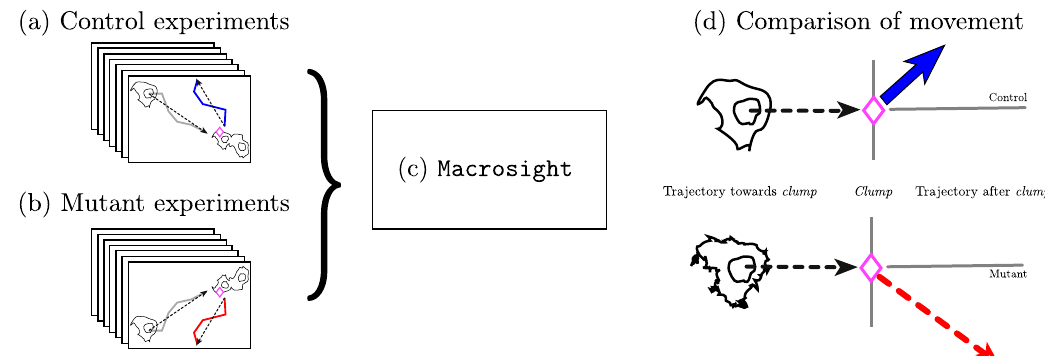
Figure 1. Illustration of the main hypothesis in this work. Different movement patterns from control and mutant samples are expected as a result of the movement analysis performed. The diagram shows the two different types of cells: controls ( a ) and mutants ( b ) being processed with macrosight [33] ( c ). The output ( d ) consists of measurements of the cell’s trajectories and the changes in direction upon interactions represented by the different types of line and colours in the